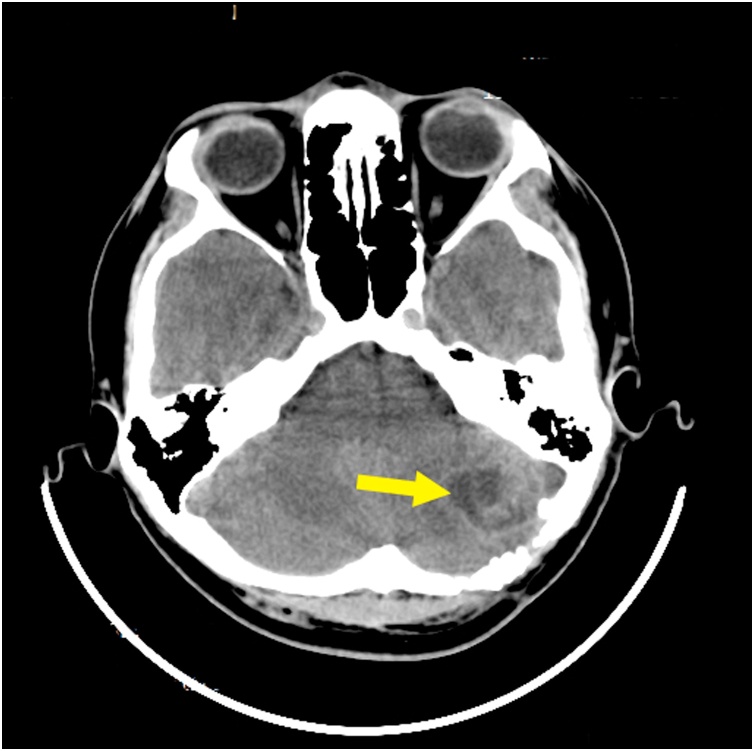
Three month postoperative enhanced head CT images showed the brain abscess was relatively consistent with its previous size, shape, and location.